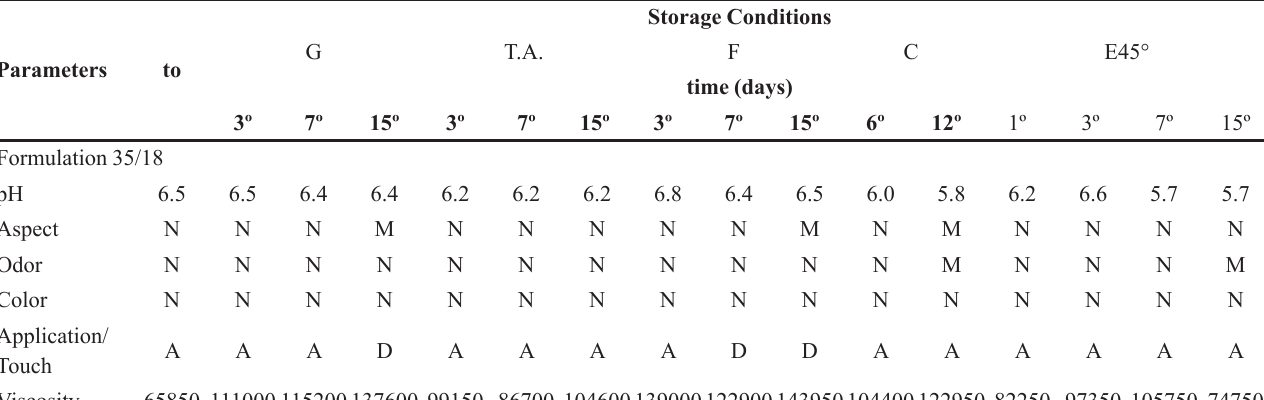
TABLE V - Evaluation of the organoleptic characteristics, pH and apparent viscosity of formulation F35/18 , in the Accelerated Stability